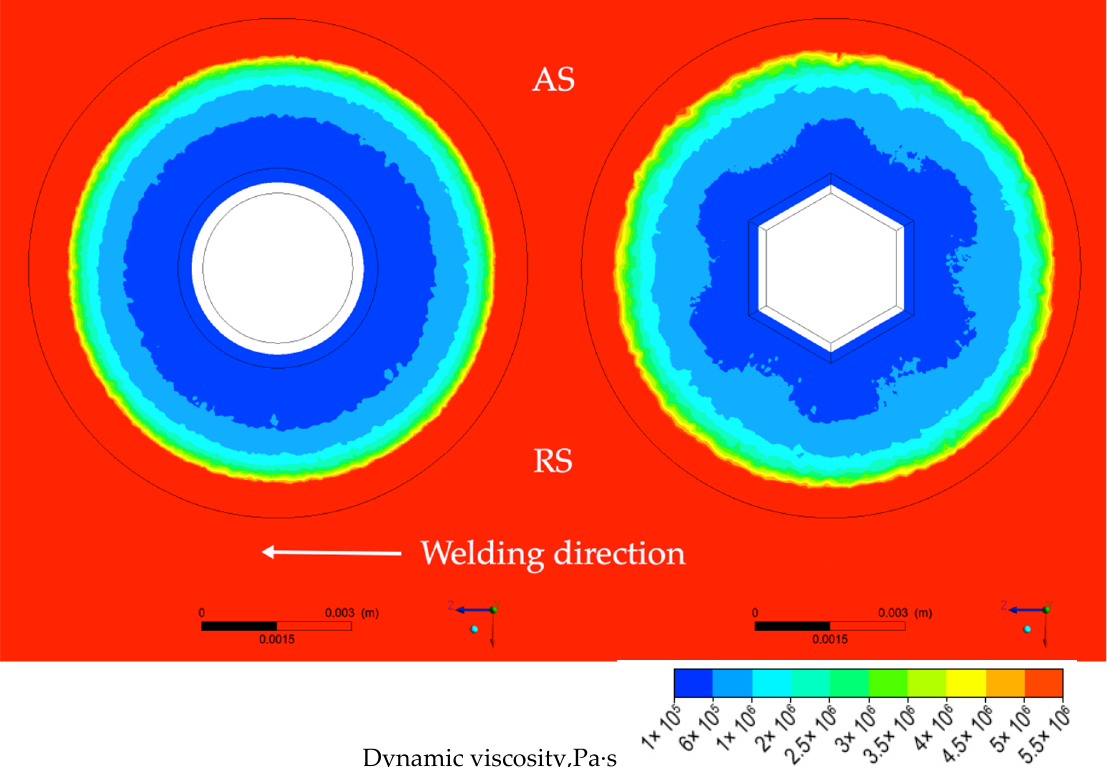
Figure 12. The distribution of the dynamic viscosity and strain rate in the plane of the welded sheets at a distance of half of